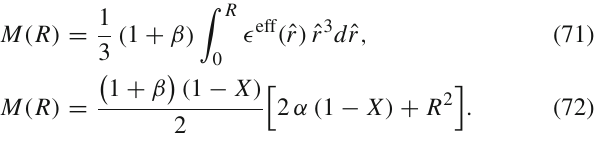
(left panel). Figure 5 shows the anisotropy arising from the MGD contribution. We note that (cid:17) MGD is positive in both the left panel (varying α ) and the right panel (varying β